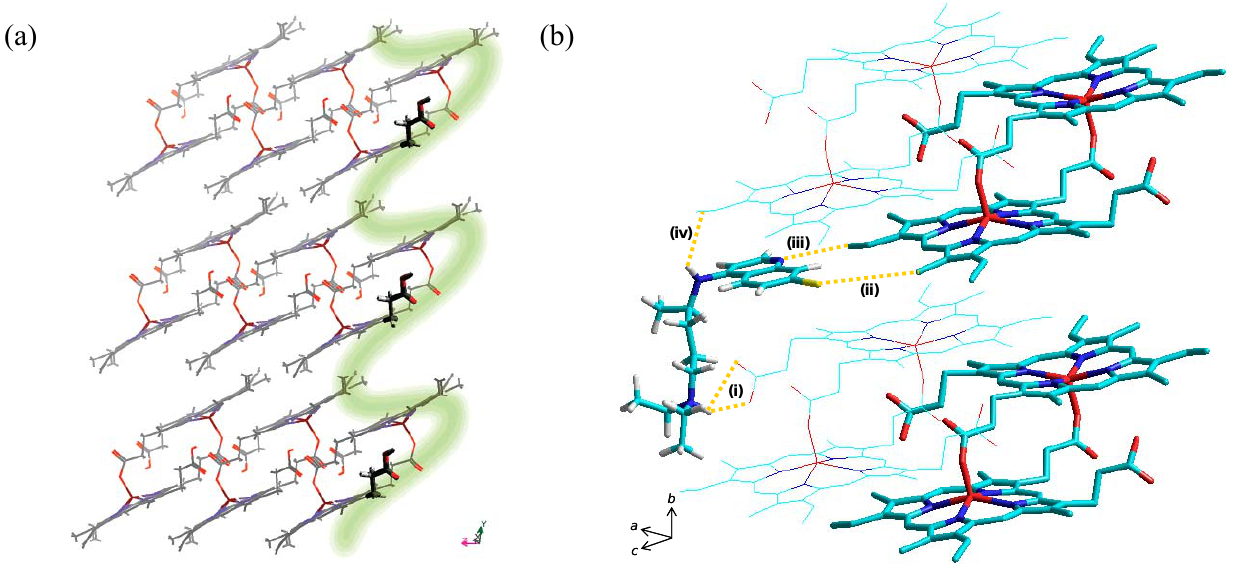
Figure 6. (a) A model of β -haematin viewed along the a axis. The corrugation of the (001) face is indicated by the green line. Reprinted with permission from reference